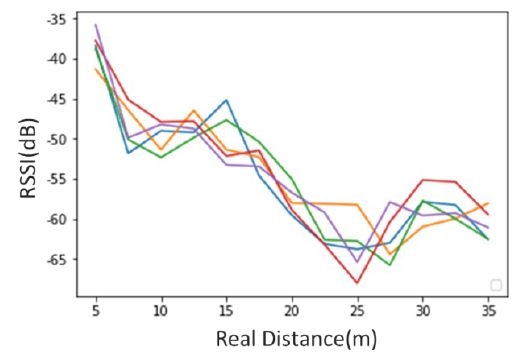
Figure 4. Experimental RSSI decay over distance of 20 m from AP in Figure 1(b)